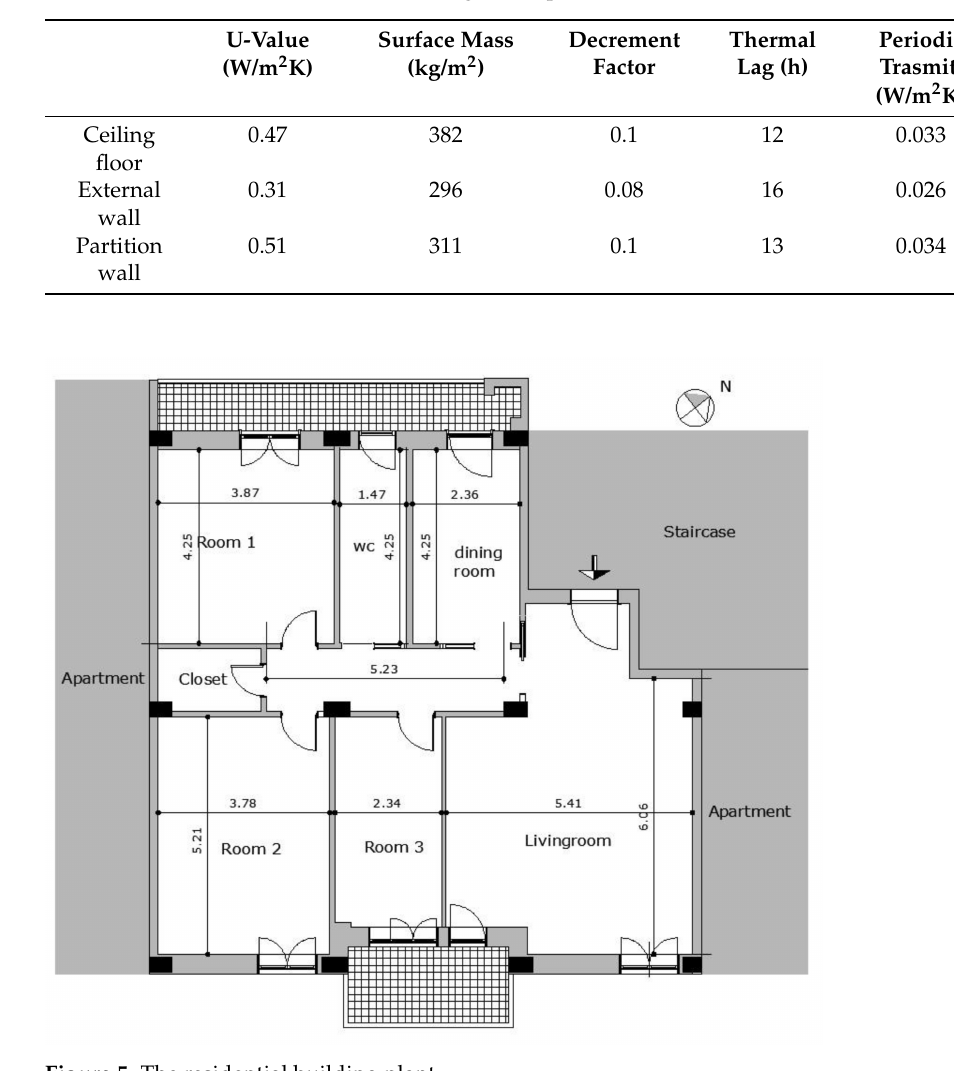
Figure 5. The residential building